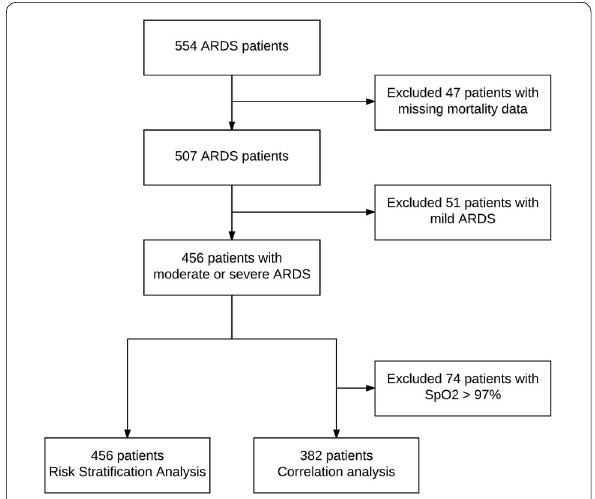
Fig. 1 Study flowchart. SpO 2 , pulse oximetry oxygen saturation; ARDS, acute respiratory distress